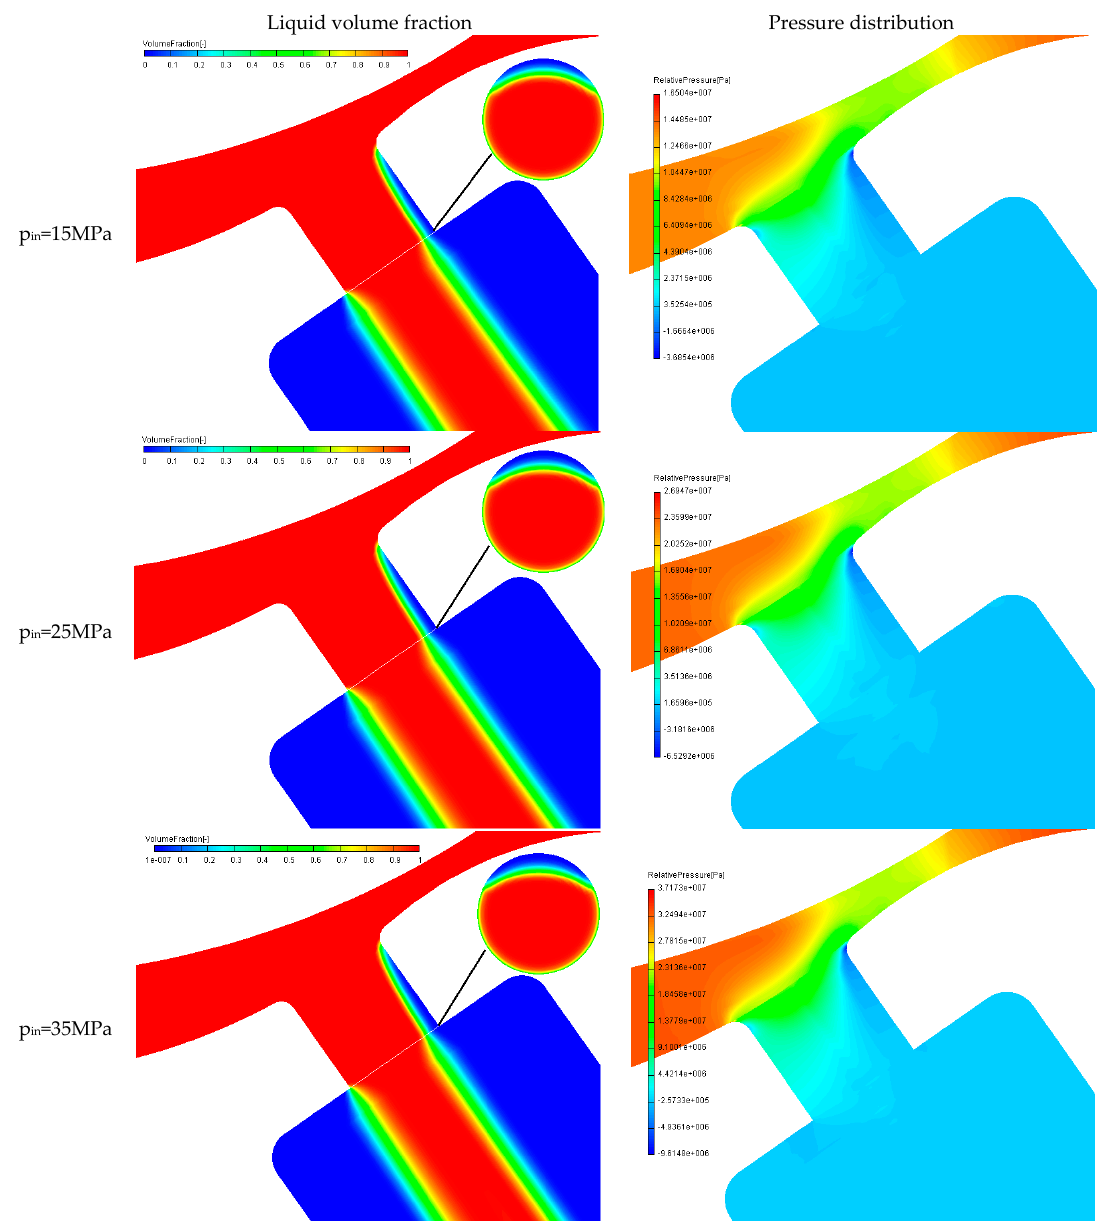
Figure 7. The cut-planes of pressure and air–liquid ratio in the nozzle under different injection pressures.